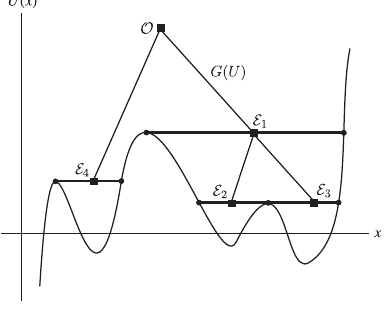
Figure 2. A Morse potential U has six critical points and satisfies (B2). The function U has four CS E 1 , E 2 , E 3 , and E 4 , which are nodes of the associated rooted tree G ( U